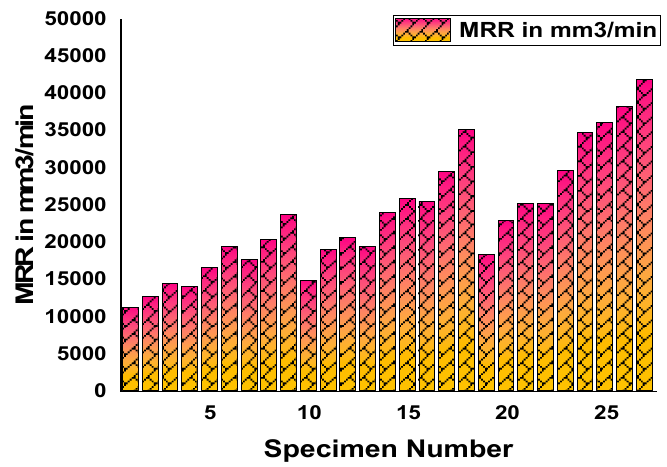
Figure 22. Material removal rates (mm 3 /min) for each specimen.